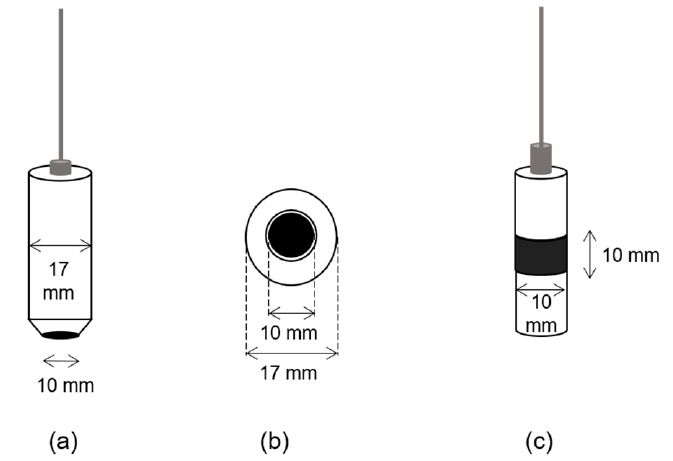
Figure 4. Anode designs with the same dimensional length of 10 mm; ( a ) the horizontal anode with surface area 0.79 cm 2 45 degrees angle chamfered boron nitride edges (with small BN shielding around carbon surface, less than 1 mm), ( b ) the horizontal anode shown from below and ( c ) the vertical anode with surface area 3.14 cm 2 .